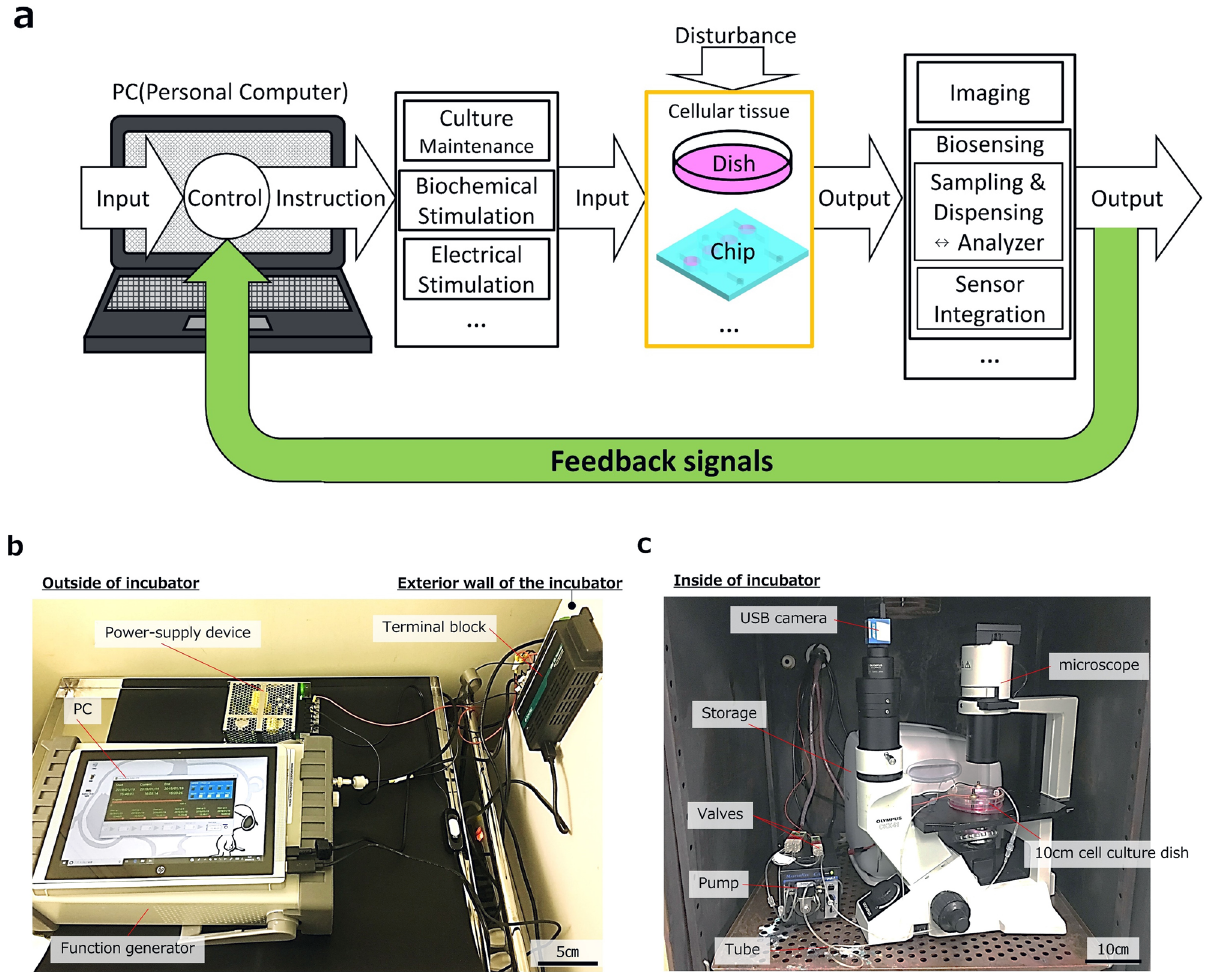
Figure 1. Conception and composition of a PC-controllable cell and tissue system. ( a ) Schematic image of a system composed of subsystems for feedback control. The system is composed of subsystems in charge